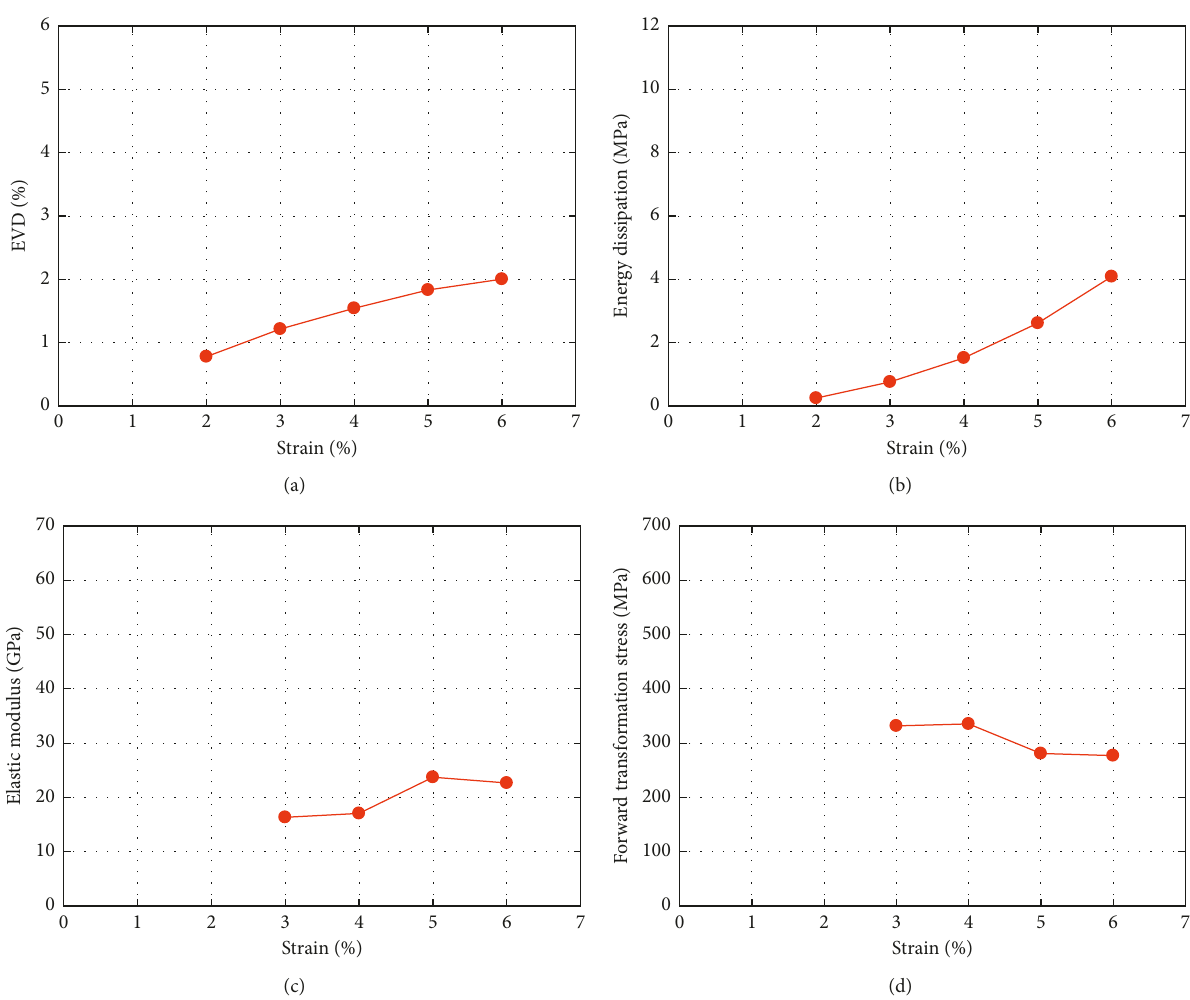
Figure 13: Effect of strain amplitude on mechanical properties. Effect on (a) EVD, (b) energy dissipation, (c) elastic modulus, and (d) forward transformation